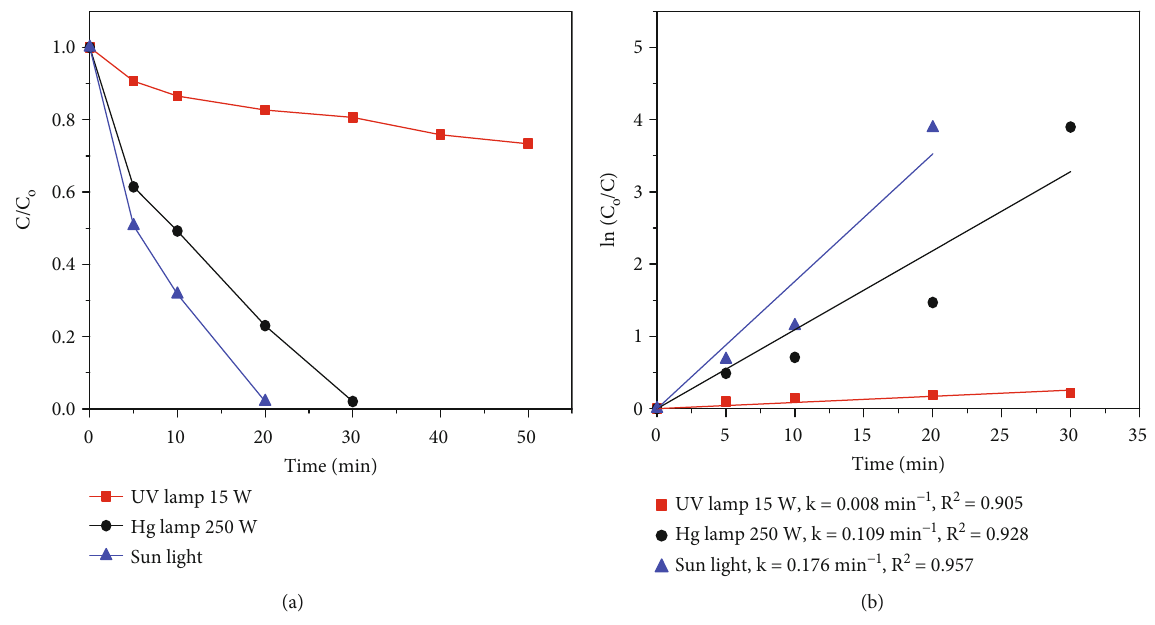
Figure 12: (a) E ff ect of di ff erent light sources on degradation of TA and (b) the kinetic curves. The reaction conditions: the reaction conditions: catalyst dosage of 0.5g/L, TA concentration of 10mg/L, and pH solution of